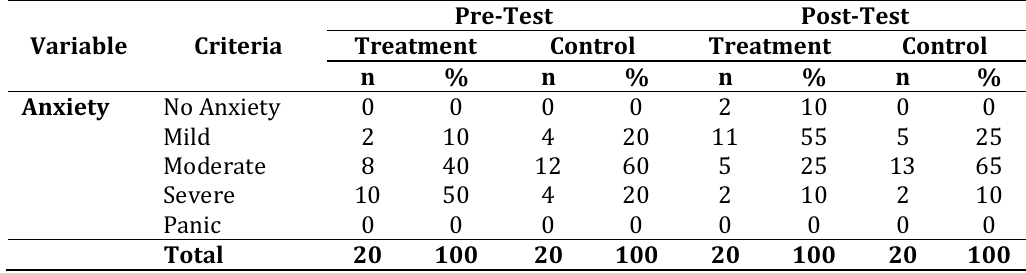
Distribution of anxiety values in children before and after intervention in Srikandi Room Jombang Hospital in 2021